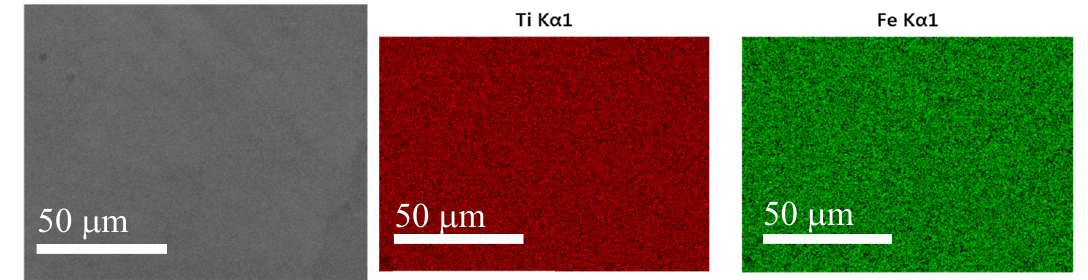
Figure 5. Secondary electron micrograph and EDX mapping of TiFe alloy.